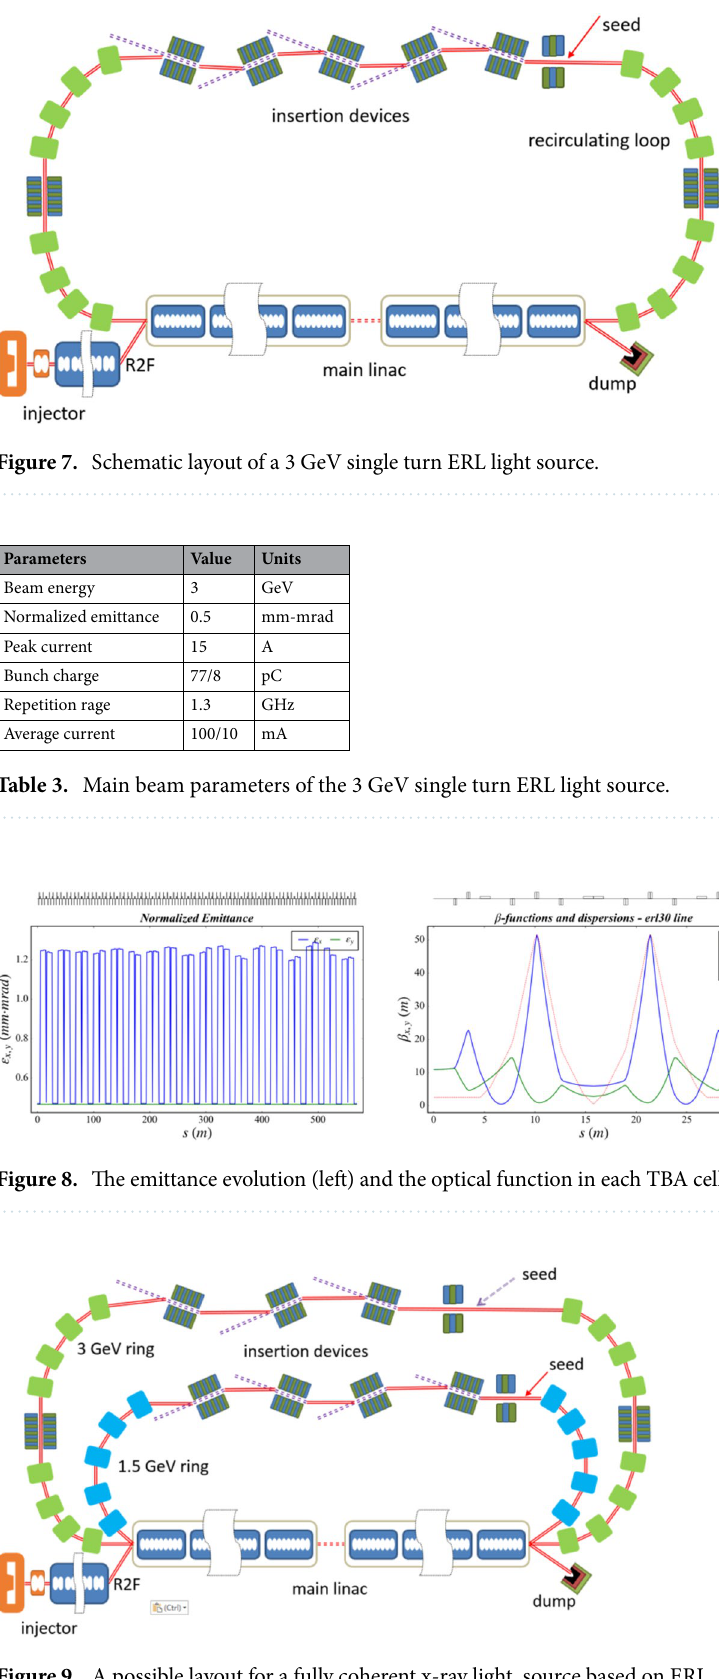
Figure 9. A possible layout for a fully coherent x-ray light source based on